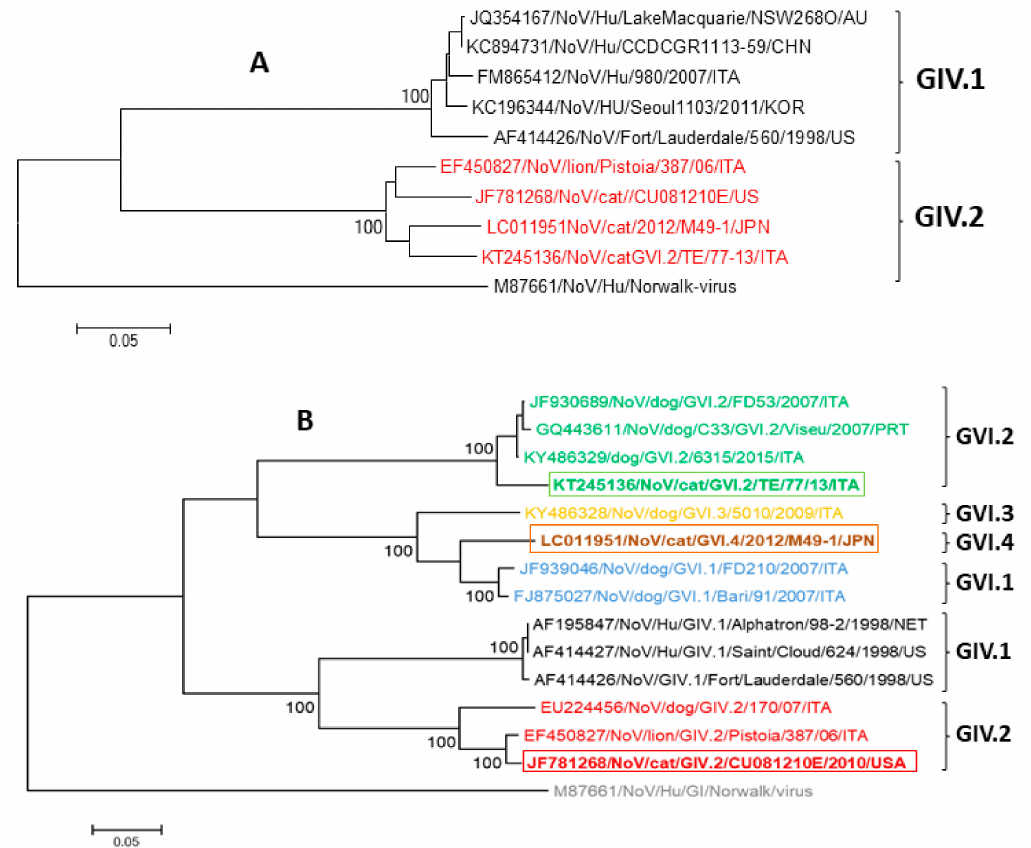
Figure 1. ( A ) Phylogenetic analysis based on the 750-nt sequence of the COOH terminus of the polymerase complex (RdRp) of GIV NoVs. The tree was generated using the neighbor-joining method and the Kimura two-parameter model. ( B ) Phylogenetic tree based on the full-length of the aa sequence of the VP1 protein of GIV and GVI NoVs, generated using the neighbor-joining method and Poisson correction. The rectangle delimits the VP1 sequences detected in